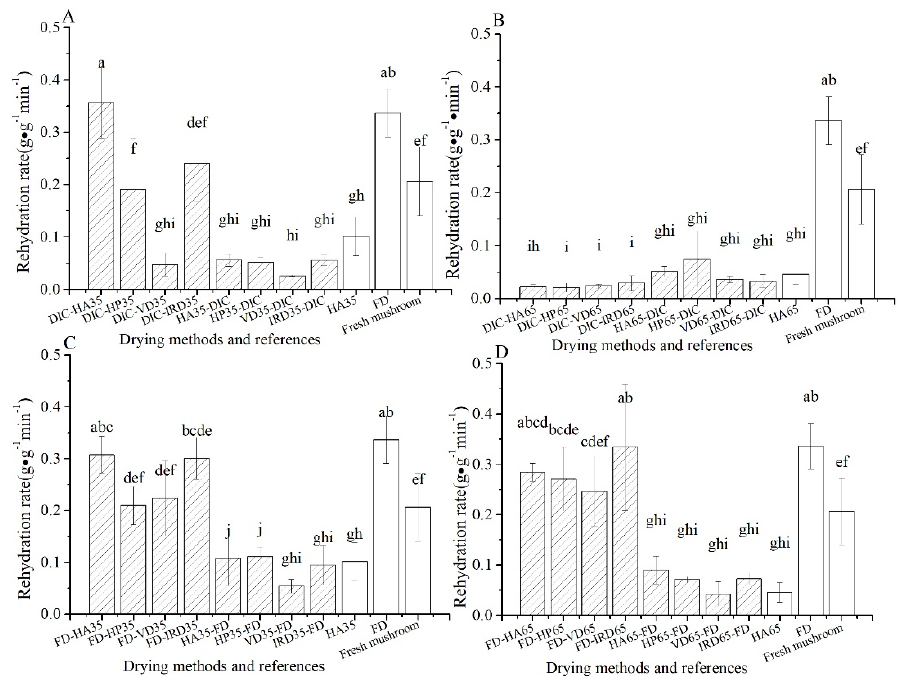
Figure 2. Volume recovery ratio of mushrooms after rehydration with different drying methods ( ) and references ( □ ). ( A–D ): group names as shown in Table1. ) and references ( (cid:3)